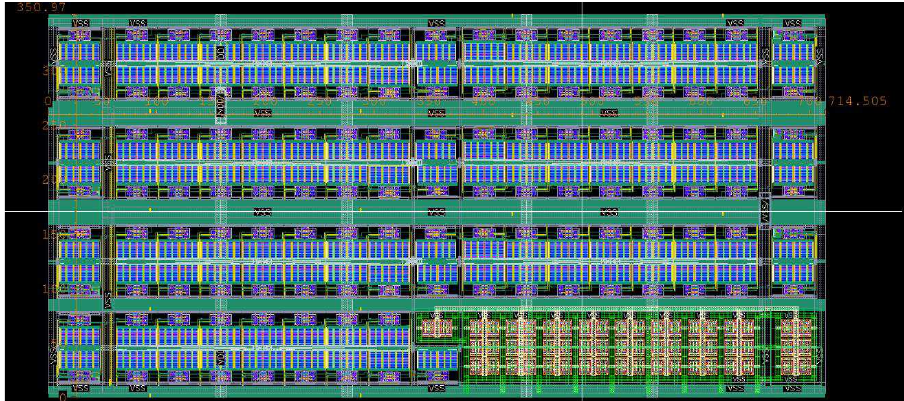
Figure 29. Layout design of the implemented tetrapolar bioimpedance